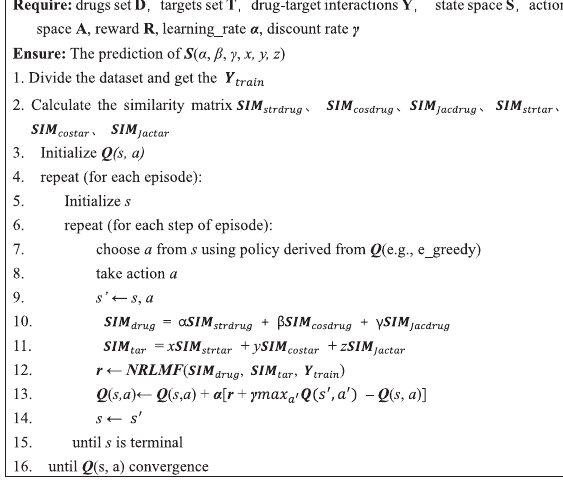
Algorithm 1. Qlnrlmf